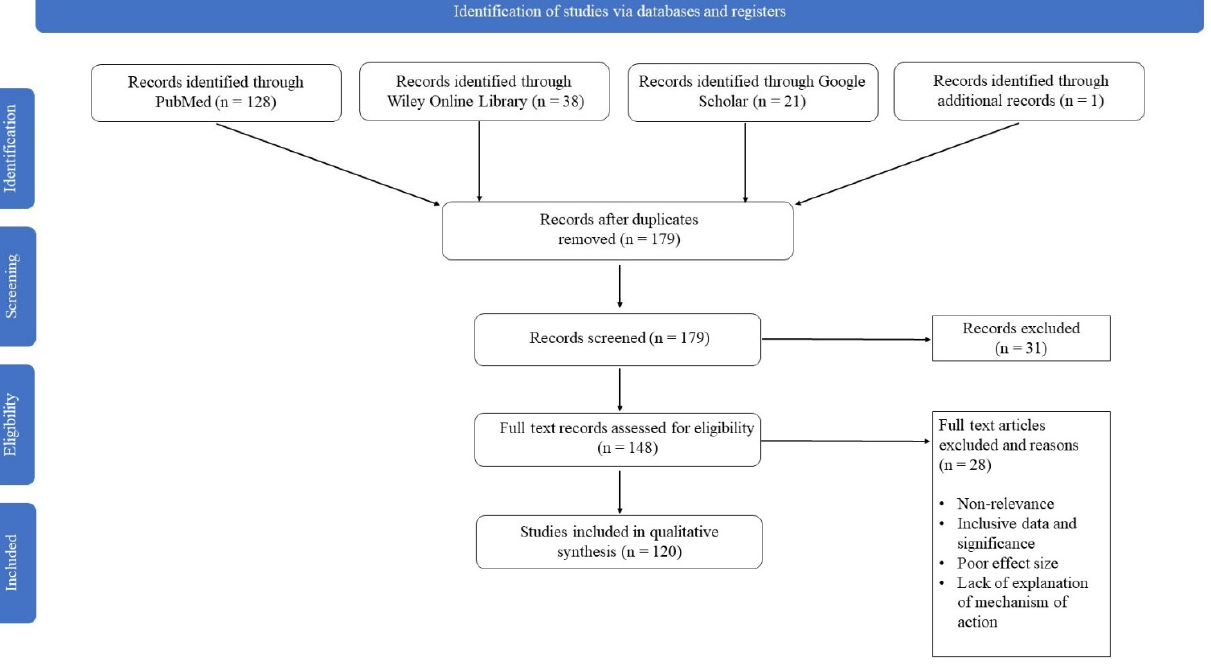
Figure 1. Chart outlining the article selection process.